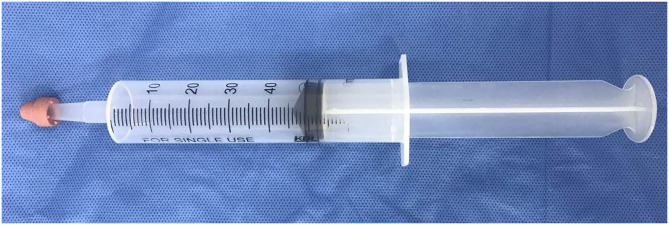
Spot pressure compressor, modified from a 50-ml air-filled syringe. Spot pressure was produced at the rubber tip by manually pressing the syringe.